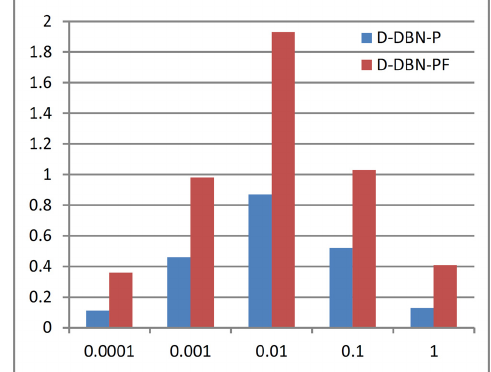
Fig. 4 Effects of parameter  on the classification performances